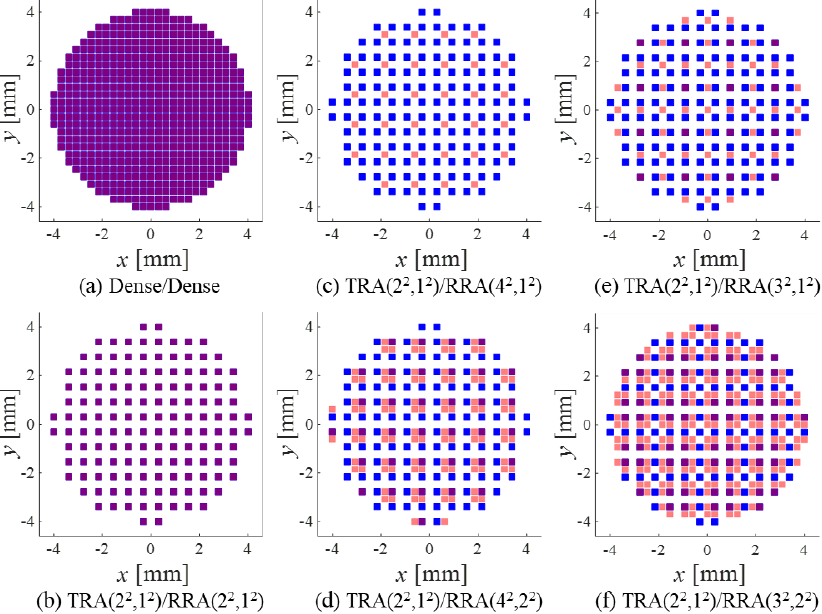
Figure 5. Transmit (blue) and receive (red) rectangular array pairs: ( a ) the dense array pair and ( b – f ) the sparse rectangular array (SRA) pairs. The overlapping elements are colored in